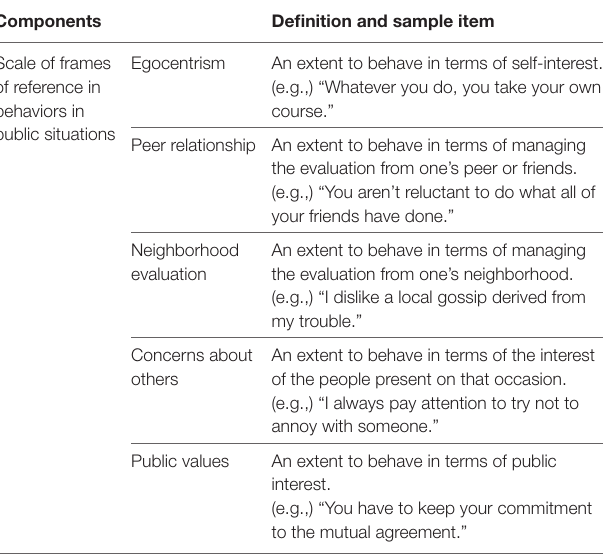
TaBle 2 | Subscale definitions and sample items for Japanese metacognitive awareness inventory (Schraw and Dennison, 1994; Abe and Ida, 2010).